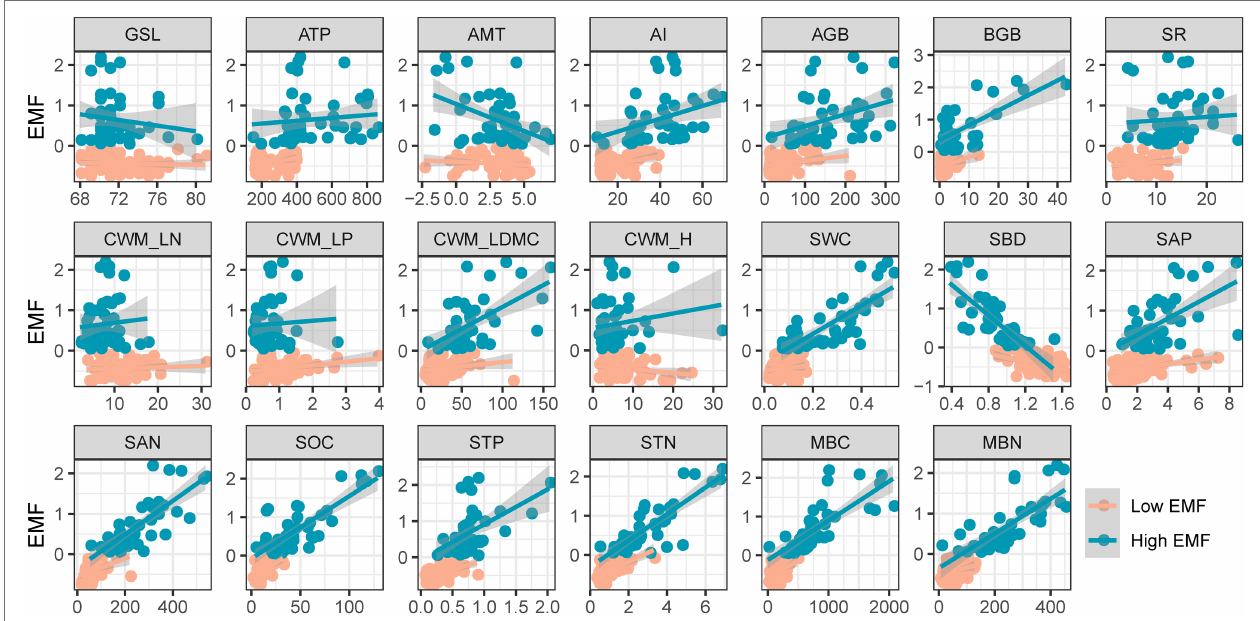
FIGURE 3 | Relationship among low and high ecosystem multifunctionality and effect factors. EMF, ecosystem multifunctionality; GSL, start of growing season to the peak of growing season; ATP, annual total precipitation (mm); AMT, annual mean temperature ( ° C); AI, aridity index; AGB, aboveground biomass (g m − 2 ); BGB, belowground biomass (g m − 2 ); SR, species richness; CWM_LN, community-weighted mean value of leaf nitrogen; CWM_LP, community-weighted mean value of leaf phosphorus; CWM_LDMC, community-weighted mean value of leaf dry matter content; CWM_H, community-weighted mean value of plant height; SWC, soil water content (%); SBD, soil bulk density (g cm − 3 ); SAP, soil available phosphorus content (mg kg − 1 ); SAN, soil available nitrogen content (mg kg − 1 ); SOC, soil organic carbon content (g kg − 1 ); STP, soil total phosphorus content (%); MBC, microbial biomass carbon content (mg kg − 1 ); MBN, microbial biomass nitrogen content (mg kg − 1 ). Red and green lines are the fitted lines from ordinary least squares regressions. Shaded areas show the 95% CI of the fit.